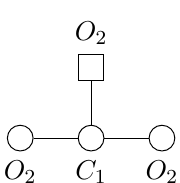
Figure 63. Quiver obtained from brane systems in the (cid:12)rst row of table 6. Its Higgs branch is M H = D 3